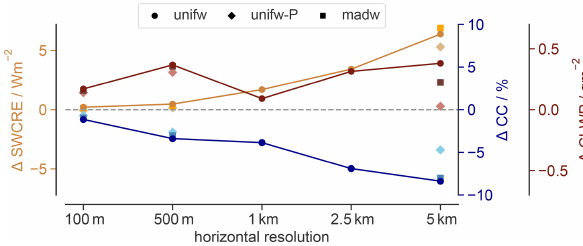
Figure 9. Shallow cumulus cloud feedback across resolutions: (cid:49) SWCRE, (cid:49) CC and (cid:49) CLWP between the perturbed warmer and control simulations for all experiments.